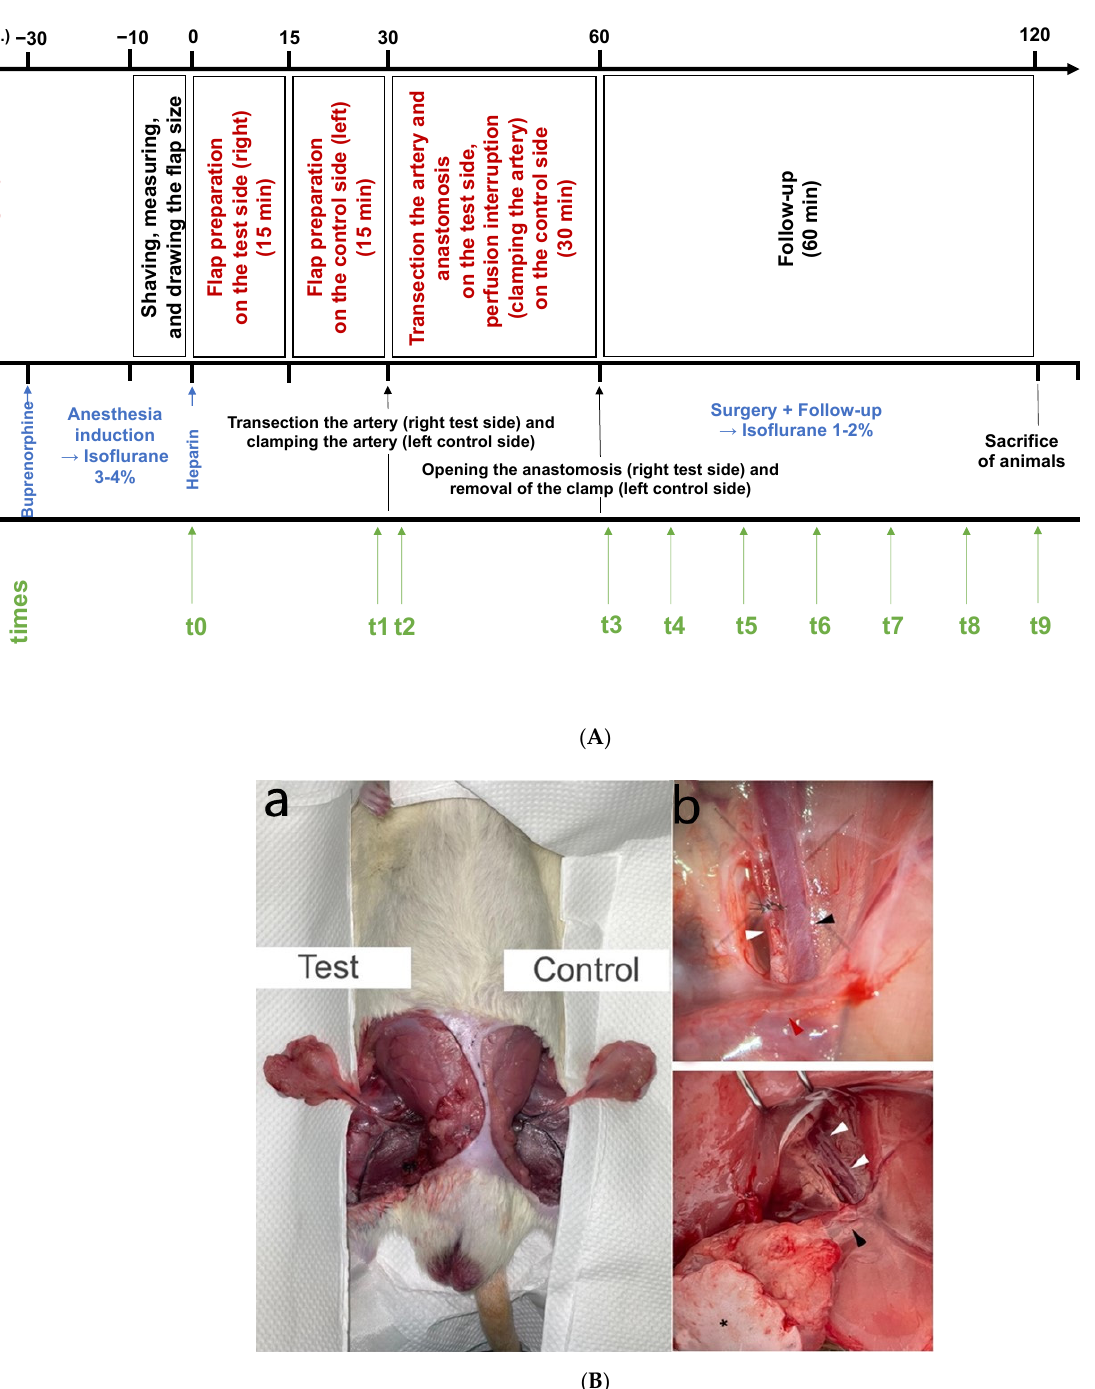
Figure 1. ( A ) Project timeline showing anesthesia, surgical steps, and measurement timepoints. ( B ) Illustration of the experimental setup with (a) bilateral dissection of the groin flap and ((b), top picture) overview about the arterial anastomoses. The femoral artery (white arrow) is anastomosed by 10.0 sutures. The femoral vein (black arrow) is illustrated directly below. The red arrow highlights the superficial epigastric vessels. ((b), bottom picture) Overview of the adipocutaneous groin flap on the left side of the rat. The femoral vessels (white arrows) and the superficial epigastric vessels (black arrows) create the flap pedicle, artery, and vein, respectively. The flap consists of a skin isle (black asterisk) and the underlying subcutaneous fatty tissue. For detailed anatomical information, see Wallmichrath et al. [31].